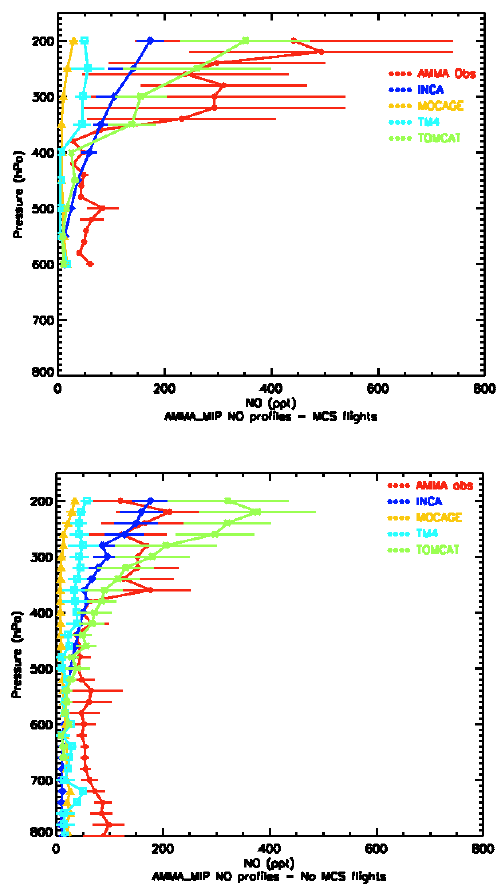
Fig. 13. Vertical profiles of NO mixing ratios observed during the AMMA campaign in August 2006 by the DLR Falcon 20 and simu- lated by the MOCAGE, INCA, TM4 and p-TOMCAT CTM’s. (top) observations that have been impacted by deep convection in the pre- vious 3–4 days (CONV cases) (bottom) observations that have not been impacted by deep convection (NOCONV